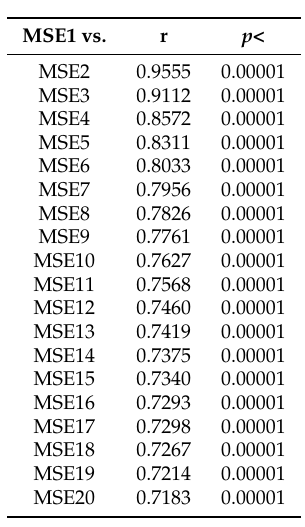
Table A18. Spearman correlations between MSE1 versus MSE2–MSE20 in neutral affect. MSE1 vs. r p